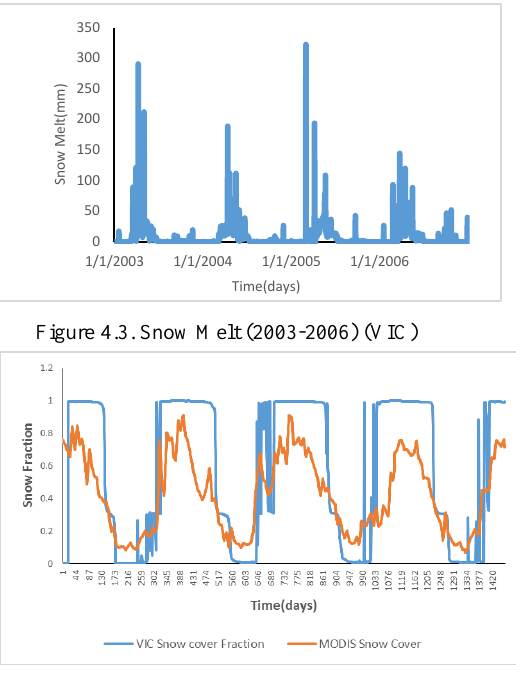
Figure 4.1. Simulated Water balance components